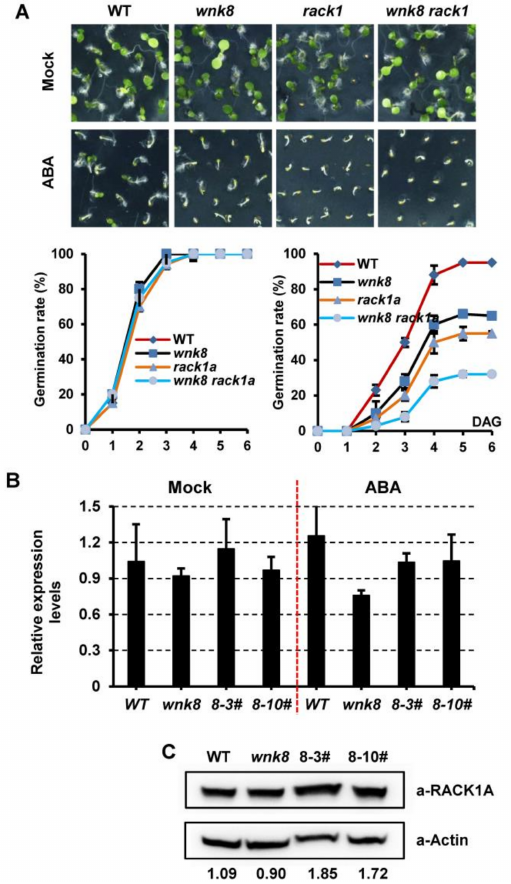
Figure 6. WNK8 and RACK1A coordinate ABA signaling. ( A ) WNK8 genetically interacts with RACK1A in response to ABA. Photographs of cotyledon expansion for indicated genotypes were shown in the absence or presence of 1.0 µ M ABA. Time course of seed germination were recorded at the lower panel. The expression of RACK1A in WNK8 related genetic background was examined at the transcriptional ( B ) and translational levels ( C